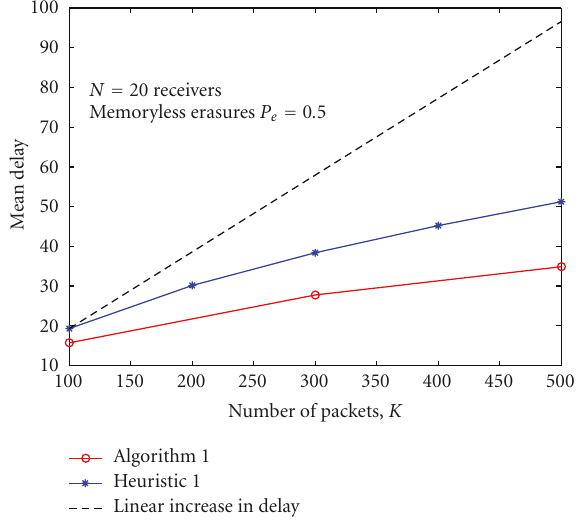
Algorithm 1 Heuristic 1 Linear increase in delay Figure 8: The e ff ect of block size on the mean delay. If the delay of transmitting K = 100 packets in Heuristic 1, d 100 , is taken as the reference, we can see that the delay of including λ × 100 packets in transmission is less than λd 100 . The same observation applies to the delay of Algorithm 1. In general, it is recommended to include all “order-insensitive” packets in making transmission decisions and only break the packets into subblocks when the assumption of order insensitivity between subblocks breaks